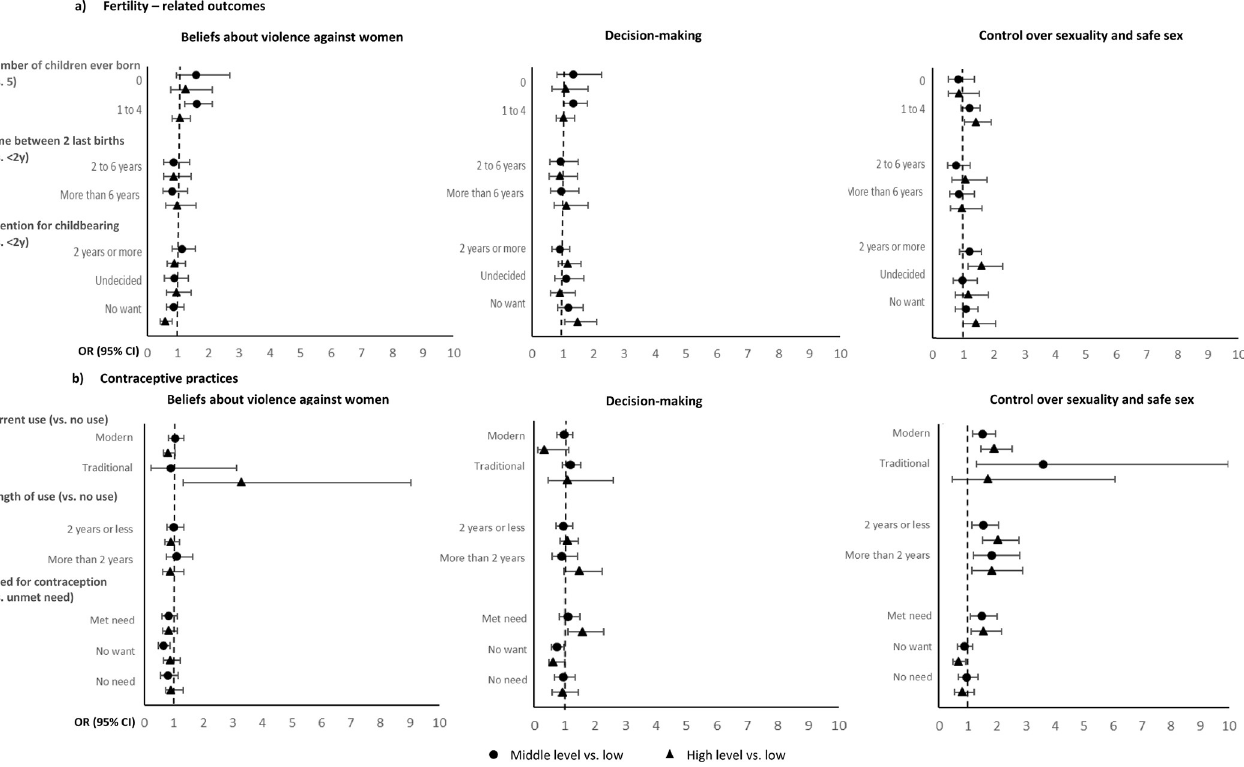
Fig 1. Adjusted odds ratio with 95% CI from multinomial regression analysis to identify the association between the domains of women’s empowerment and a) Fertility related outcomes (adjusted for number of live children, age, education and region), and; b) contraceptive practice (adjusted for number of live children, age,